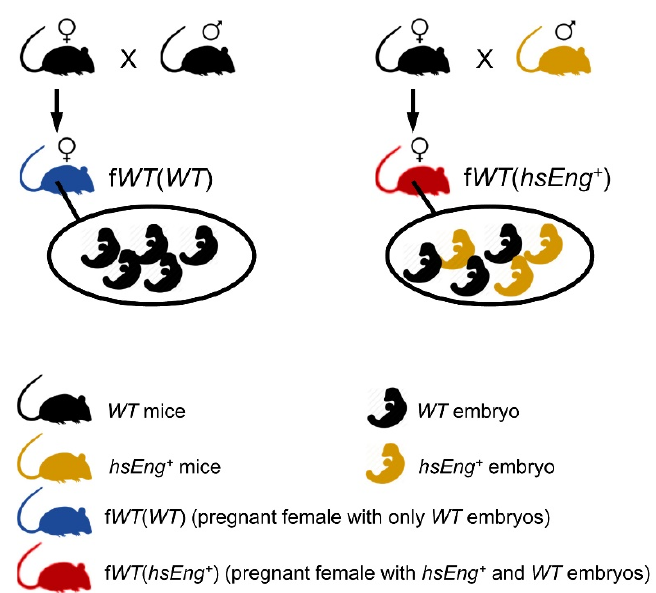
Figure 1. Description of the animal model. Wild type (WT) female mice crossed with transgenic male mice overexpressing human soluble endoglin ( hsEng + ), named as f WT ( hsEng + ), carry both WT and hsEng + embryos. WT female mice crossed with WT male mice, named as f WT ( WT ), carry only WT embryos.